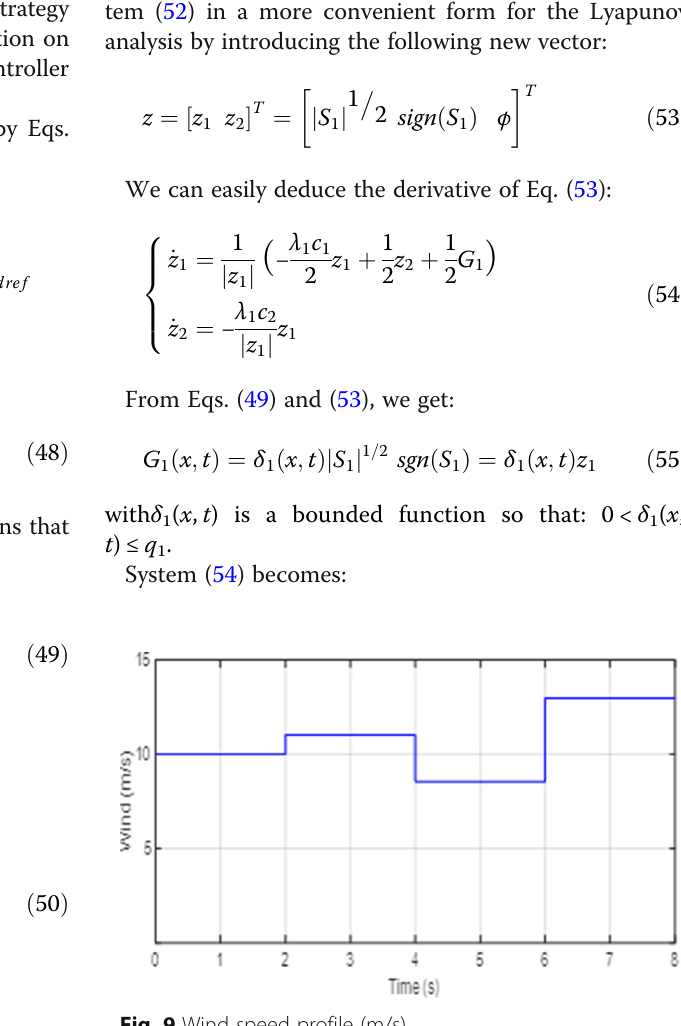
Fig. 9 Wind speed profile (m/s)